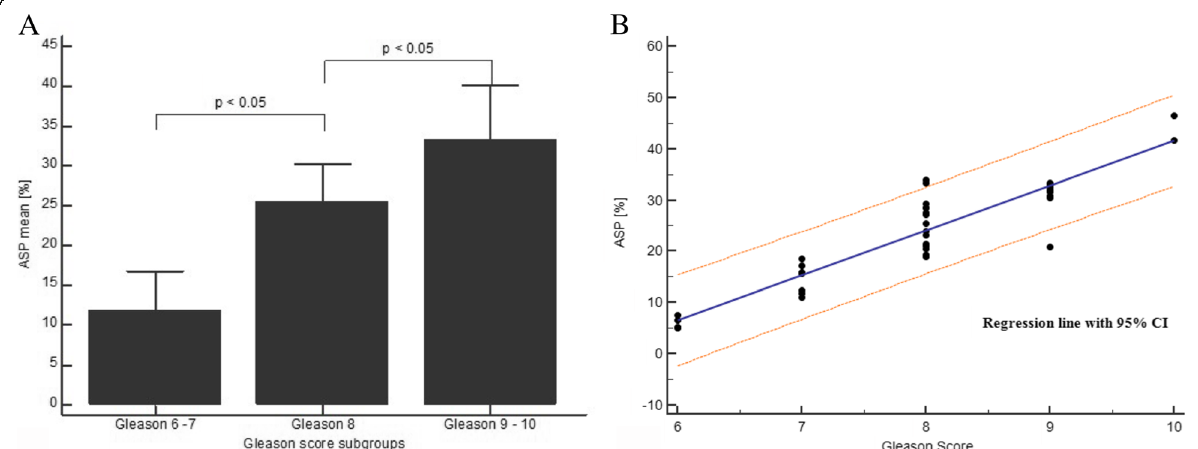
Fig. 3 Differences between the asphericity for prostate cancer lesions with a Gleason score of 6 – 7, 8, and 9 – 10. a The bar chart demonstrates the asphericity values for the different Gleason score subgroups. A significant difference ( p ≤ 0.05) was measured between prostate cancer lesions with a Gleason score of 6 – 7 and 8 and lesions with a Gleason score of 8 and 9 – 10. This potentially indicates that an increased tumor dedifferentiation/ heterogeneity is accompanied by a gradual rise in the asphericity. Error bars indicate standard deviations. b The scatter diagram presents the correlation of the asphericity towards the Gleason scores. The linear regression line and the 95% confidence interval is shown. ASP: